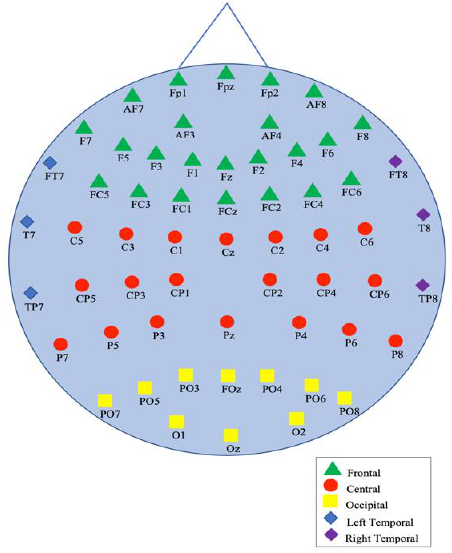
Figure 4. The locations of the electrodes for EEG signal construction [38].